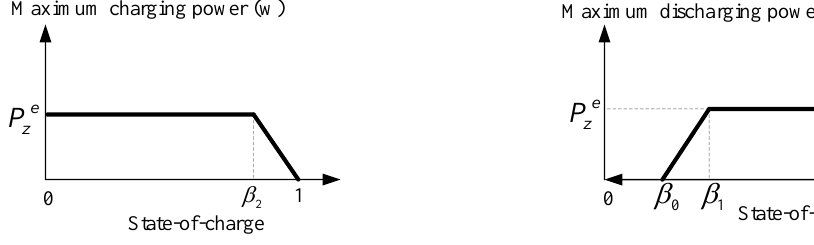
Figure 5. Maximum charging and discharging power of